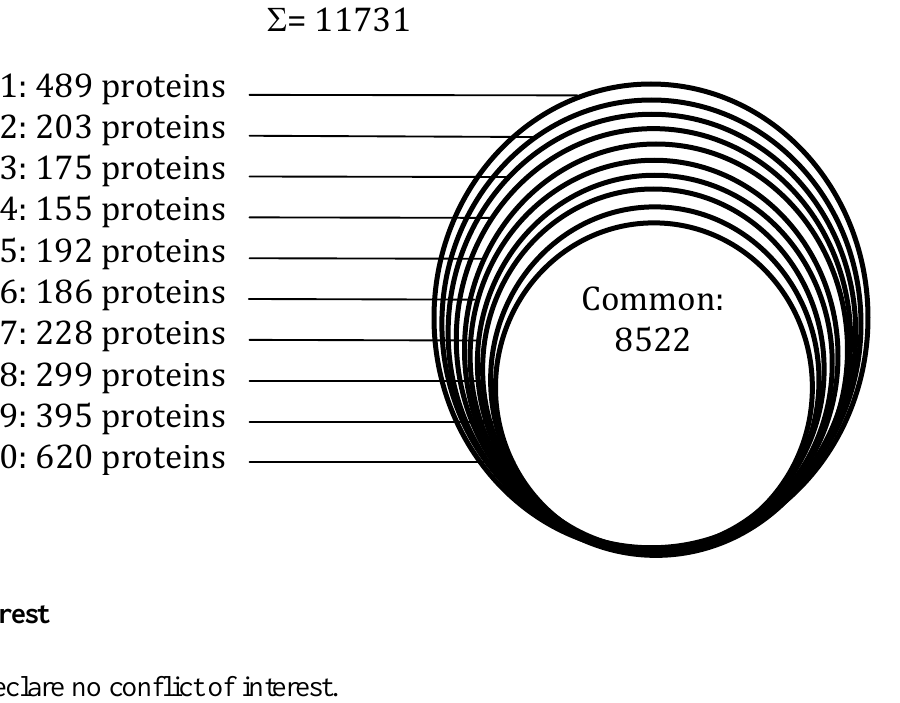
Figure 5. Venn diagrams of the proteins identified in 10 different human cell lines. Each cell exhibited an average of 10,361 species, of which 8522 proteins represented a common set and the remaining a set specific for each cell line, as indicated (modified from Geiger et al.